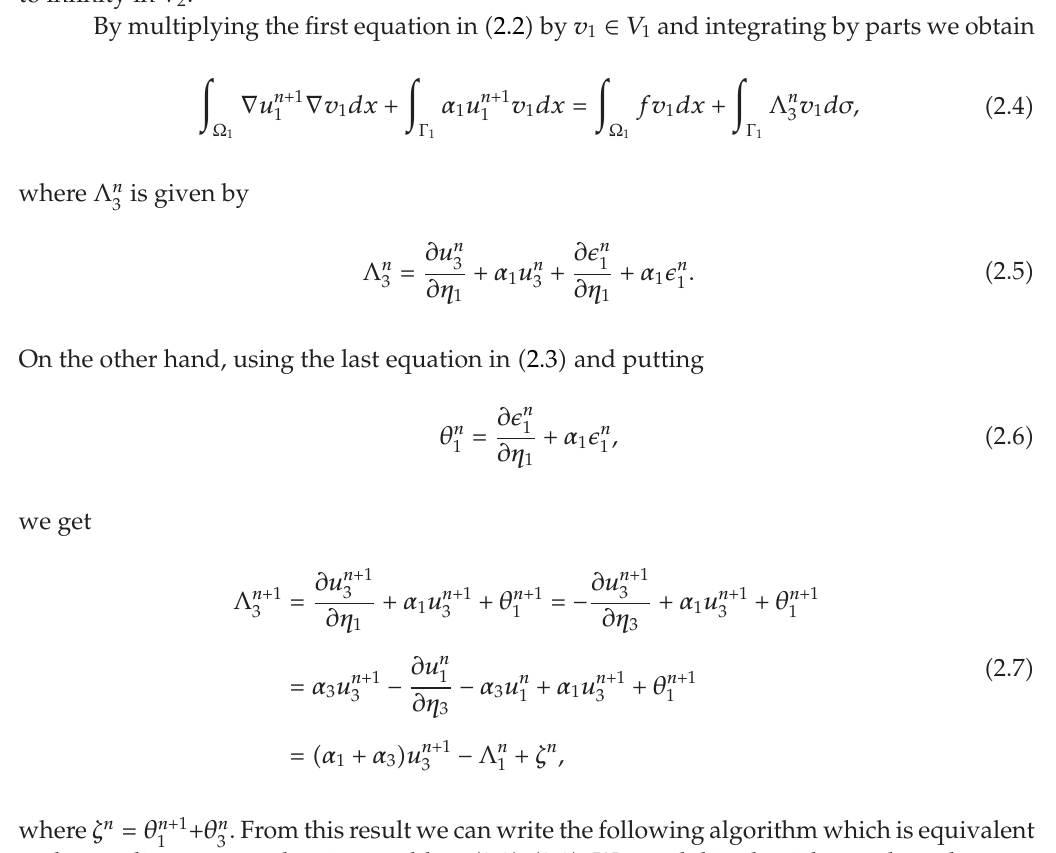
, u n (cid:11) 1 (cid:3) n ∈ N solutions of problems 3 1